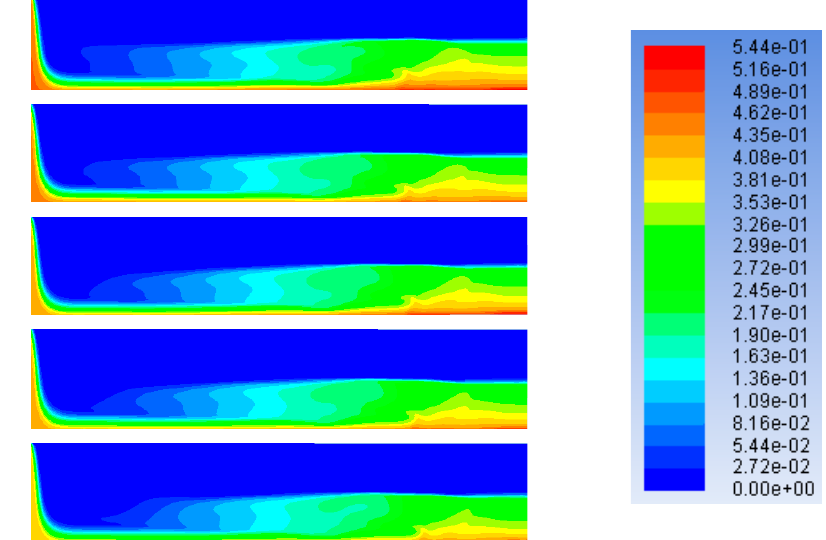
Figure 11. Gravel settlement diagram with different flow temperatures.